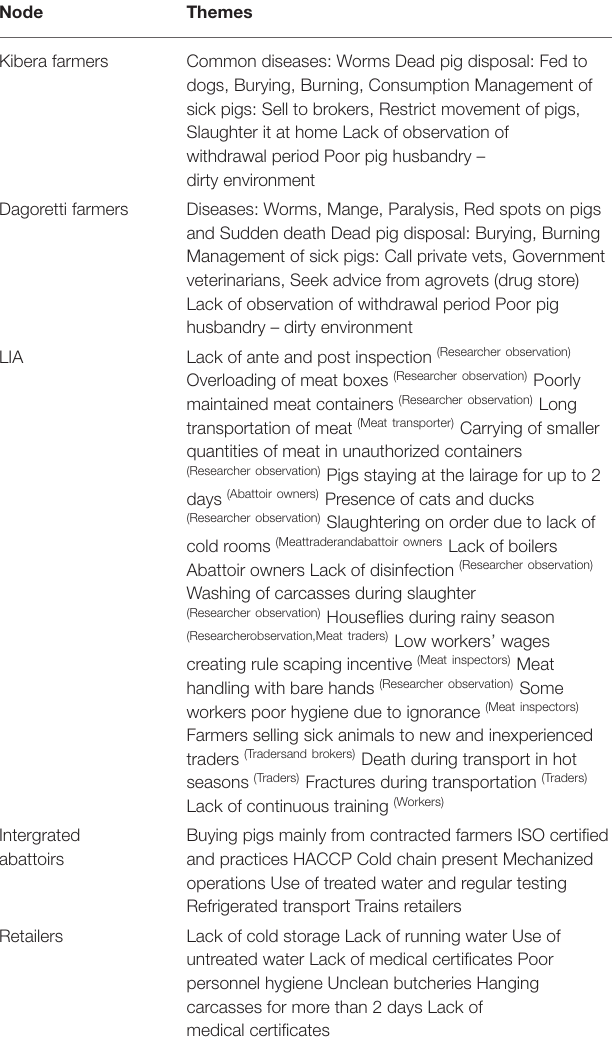
TABLE 5 | Food safety or disease management practices as by various stakeholders in Nairobi pig value chains in Nairobi.